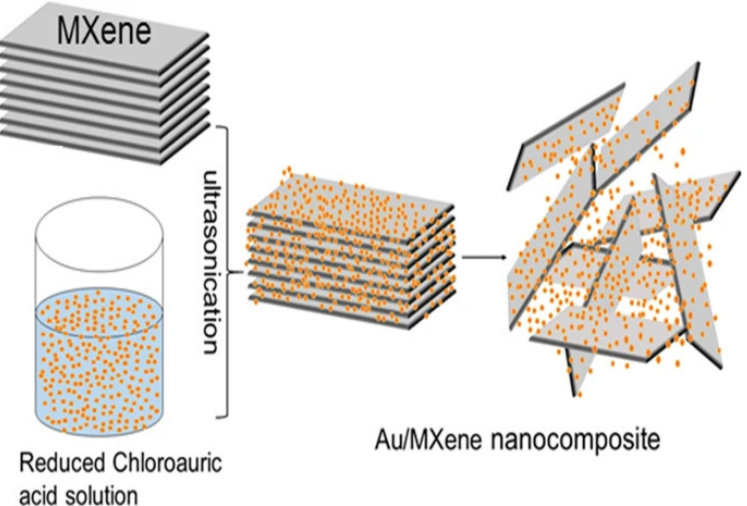
Figure 3. Preparation method for nanocomposite of gold nanoparticles and MXene [70].